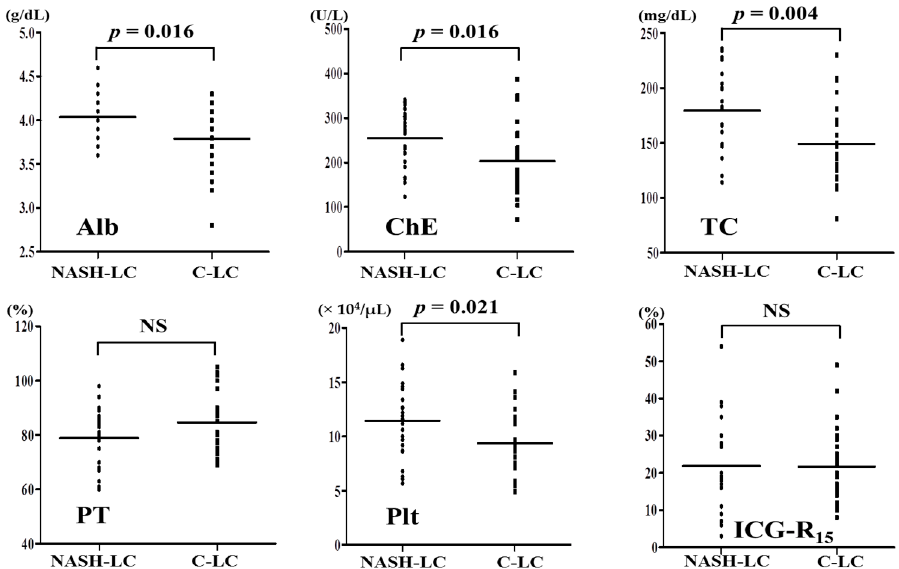
Figure 2. Comparison of each liver function test at initial LC (Child-Pugh A) in NASH-LC and C-LC. Albumin, cholinesterase, total cholesterol, and platelet count are significantly higher in NASH-LC than in C-LC ( p = 0.016, p = 0.016, p = 0.004, p = 0.021, respectively). NS: not significant; NASH-LC: liver cirrhosis related to nonalcoholic steatohepatitis; C-LC: liver cirrhosis related to hepatitis C virus; Alb: albumin; ChE: cholinesterase; TC: total cholesterol; PT: prothrombin time; Plt: platelet count; ICG-R 15 : retention rate of indocyanine green 15 min after administration.